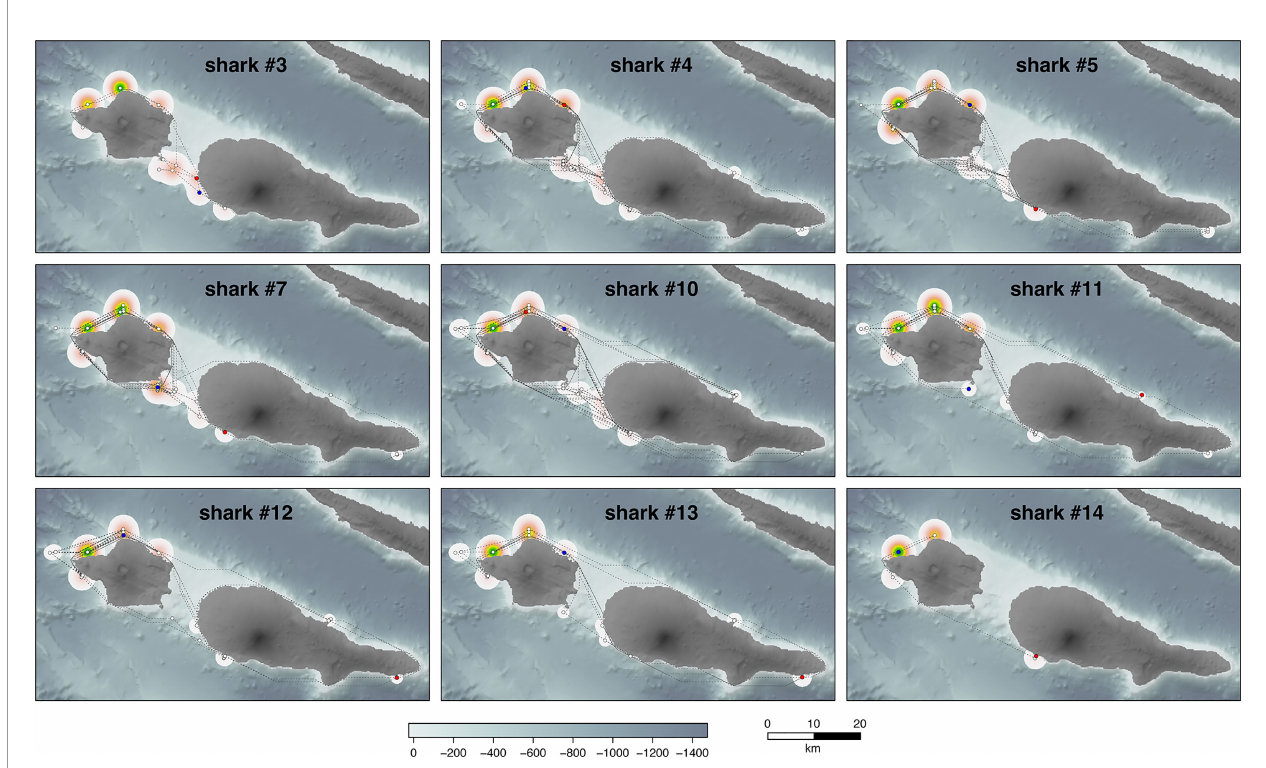
FIGURE 2 | Individual trajectory paths (dotted lines) and home ranges (kernel utilization distributions) of nine acoustically tagged juvenile smooth hammerhead shark ( Sphyrna zygaena ). Trajectories were calculated based on the shortest path between each two consecutive COAs (centre of activity positions) taking into account land surfaces; white dots mark the COA, and blue and red dots signal the fi rst and last positions, respectively, for each